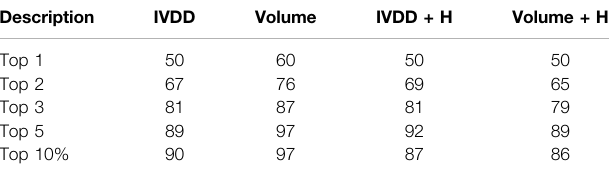
TABLE 2 | Results obtained on the PDTD subset (with and without hydrogen atoms) with the IVDD method and by a simple descending ranking of the pocket volumes. All results are referred to the orthosteric/main